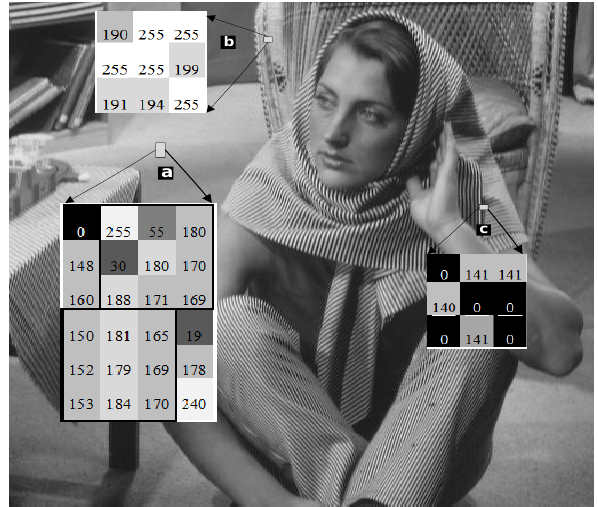
Figure 1. Shows a Barbara image in which different regions are artificially corrupted with ( a ) random value impulse, ( b ) salt like impulse and ( c ) pepper like